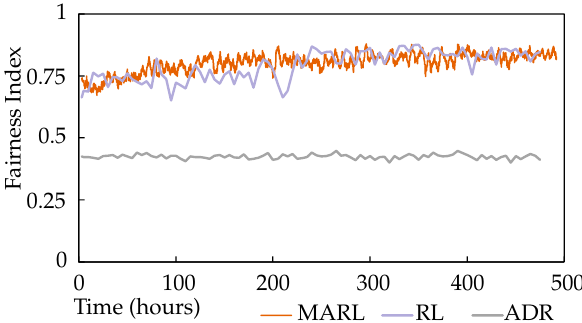
Figure 7. Scenario 1 fairness index for MARL.